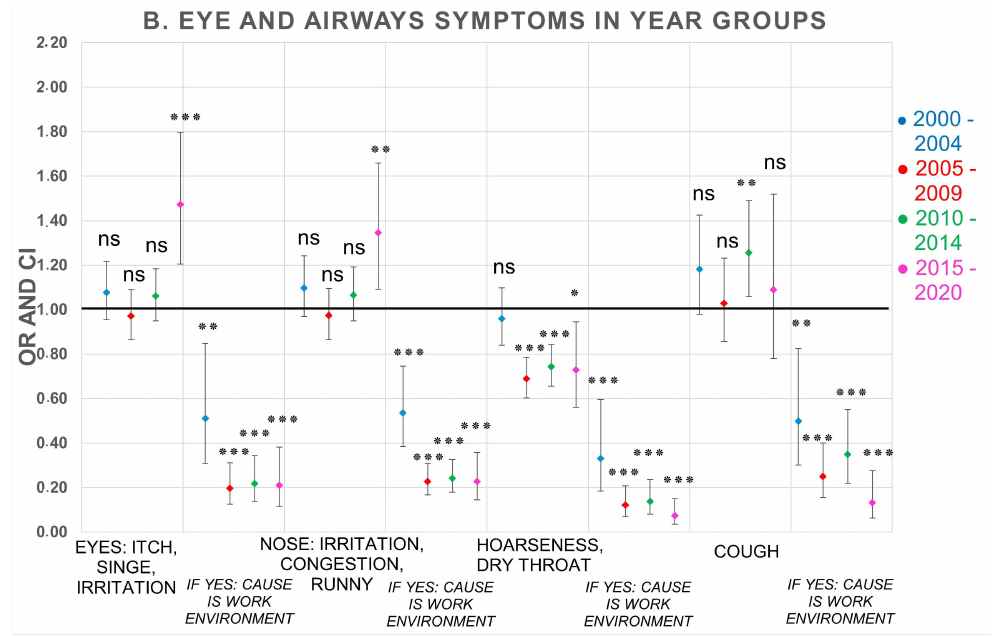
Figure 2. OR and 95% CI of 5-year groups compared to reference group (1995–1999, OR 1) for mucous-membrane symptoms and perceived causality to the office environment. Logistic regression analyses adjusted for sex and atopy. Number of respondents in each year group: 1995–1999 ( n = 4028); 2000–2004 ( n = 5348); 2005–2009 ( n = 7293); 2010–2014 ( n = 8904); 2015–2020 ( n = 790). OR = odds ratio, CI = confidence interval. p -values: * <0.05; ** ≤ 0.01; *** ≤ 0.001; ns = not significant.